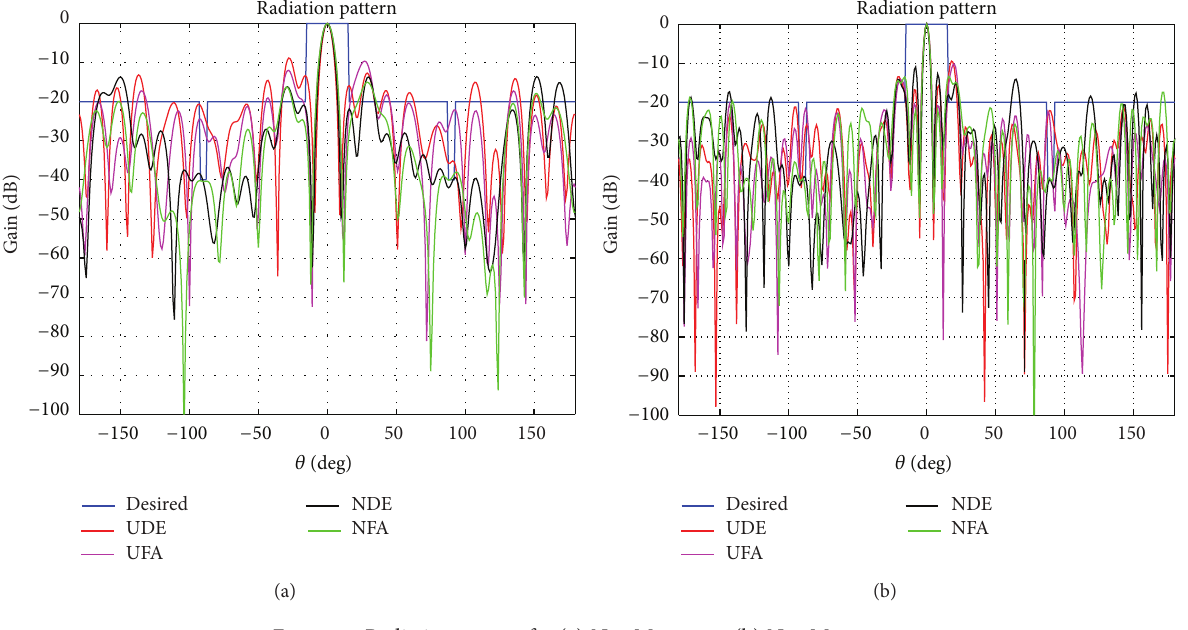
Figure 5: Radiation pattern for (a) 𝑁 × 𝑀 = 5 × 5 , (b) 𝑁 × 𝑀 = 7 × 7 .